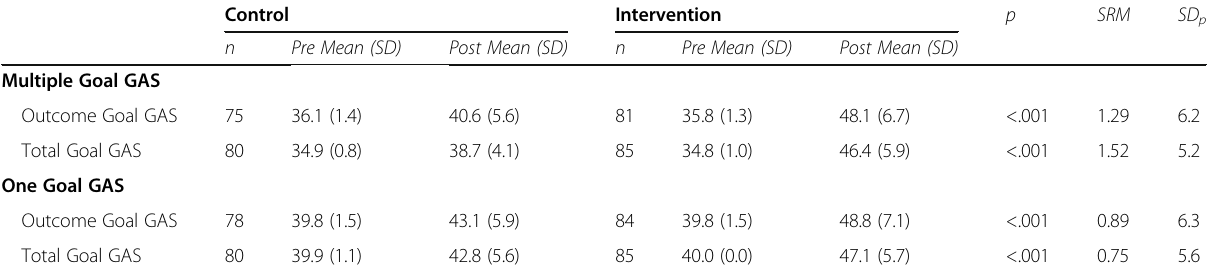
Table 4 MGAT patient- and clinician-rated GAS scores and treatment response for multiple- and one-goal GAS